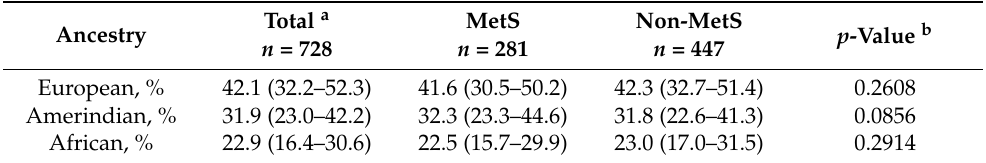
Table 2. Ancestry profile of Amazonian riverine individuals participating in this study, diagnosed with metabolic syndrome (MetS) and without it (non-MetS). Data are presented as median and interquartile ranges.